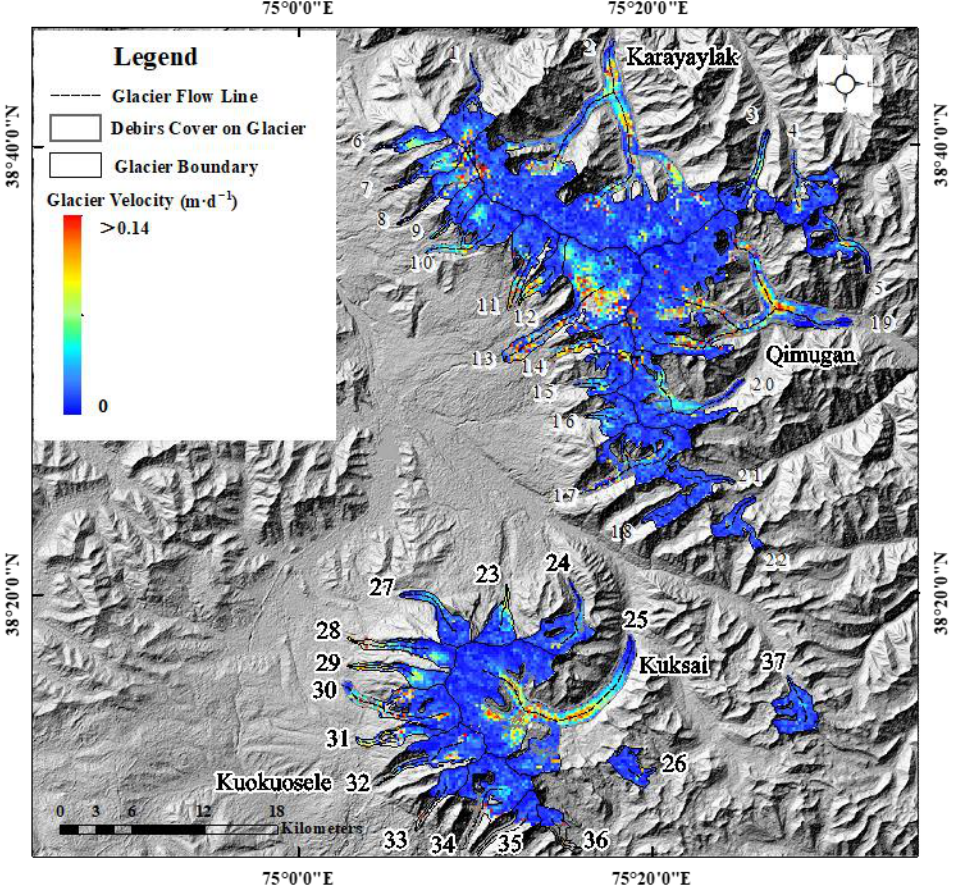
Figure 4. Velocity distribution of glaciers (>5 km 2 ) in the Muztag-Kongur Mountains from 2013 to 2021.